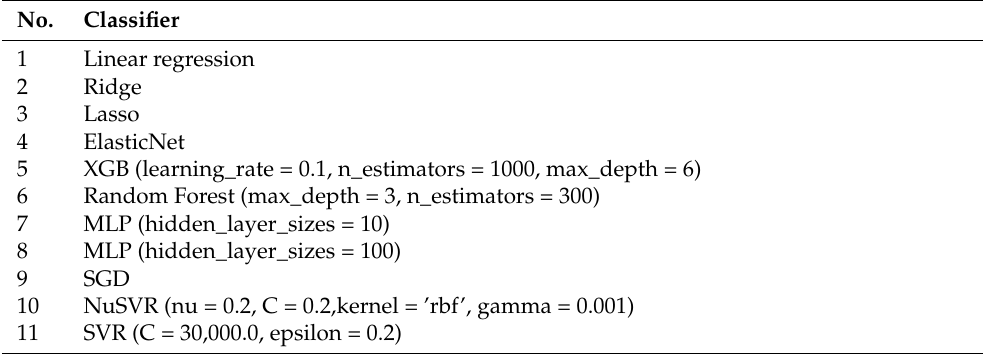
Table 5. Summary of applied